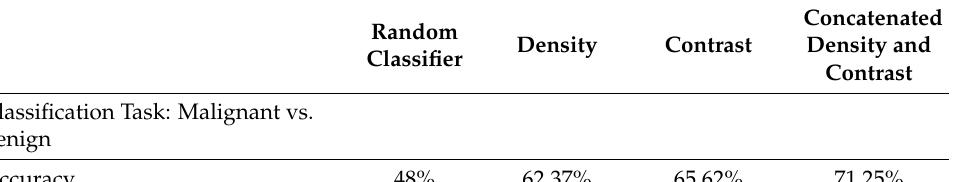
Classification Task: Malignant vs. Benign